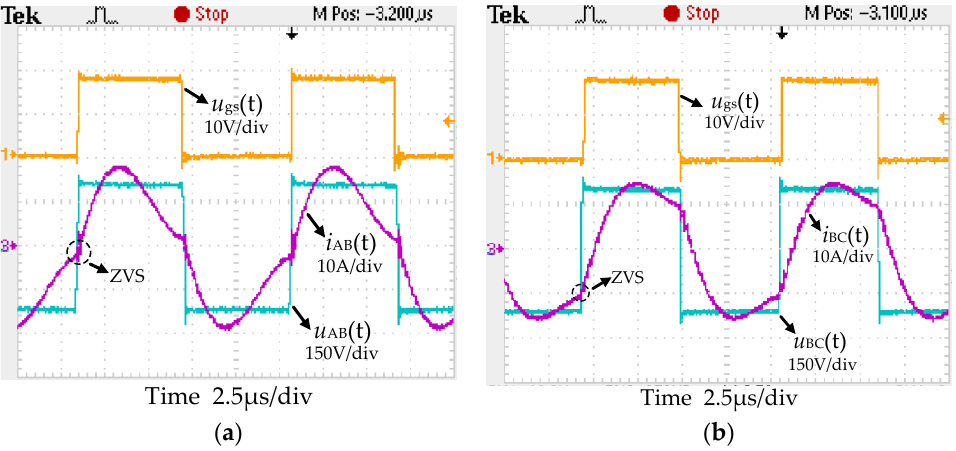
Figure 13. Waveform of inverter output voltage/current and rectifier input voltage under the ( a ) CC transmission mode and ( b ) CV transmission mode.